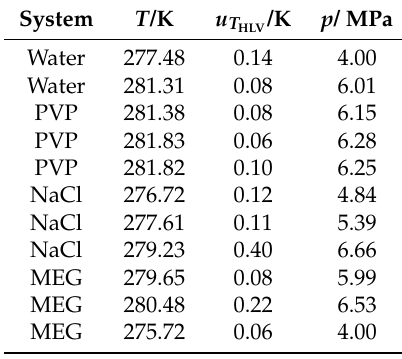
Table 2. HLV equilibrium temperature T and pressure p , for the system methane + water in the presence of different inhibitors. Standard uncertainties for temperature are shown in the table. Standard uncertainty for pressure was u p = 0.005 MPa. Average values are shown for equilibrium temperatures and pressures. At least 3 replicates were done for each condition of every system.